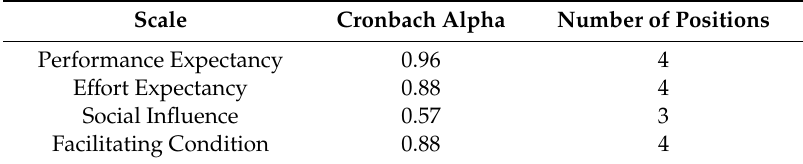
Table 2. Reliability statistics for individual subscales of the UTAUT Questionnaire.